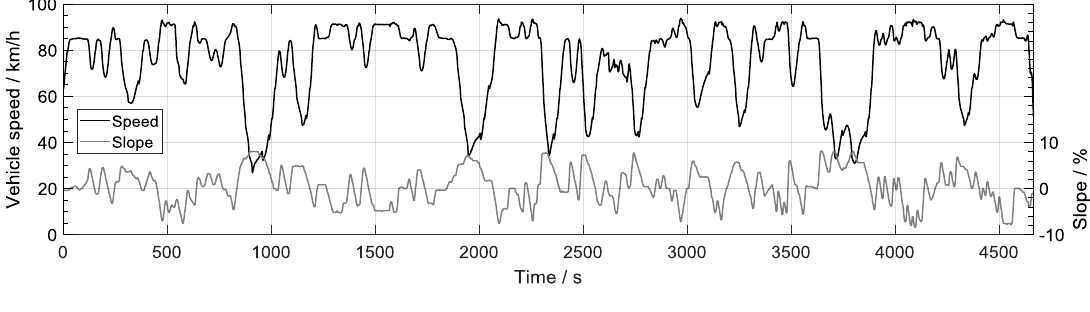
Figure 2. Real-world driving cycle.